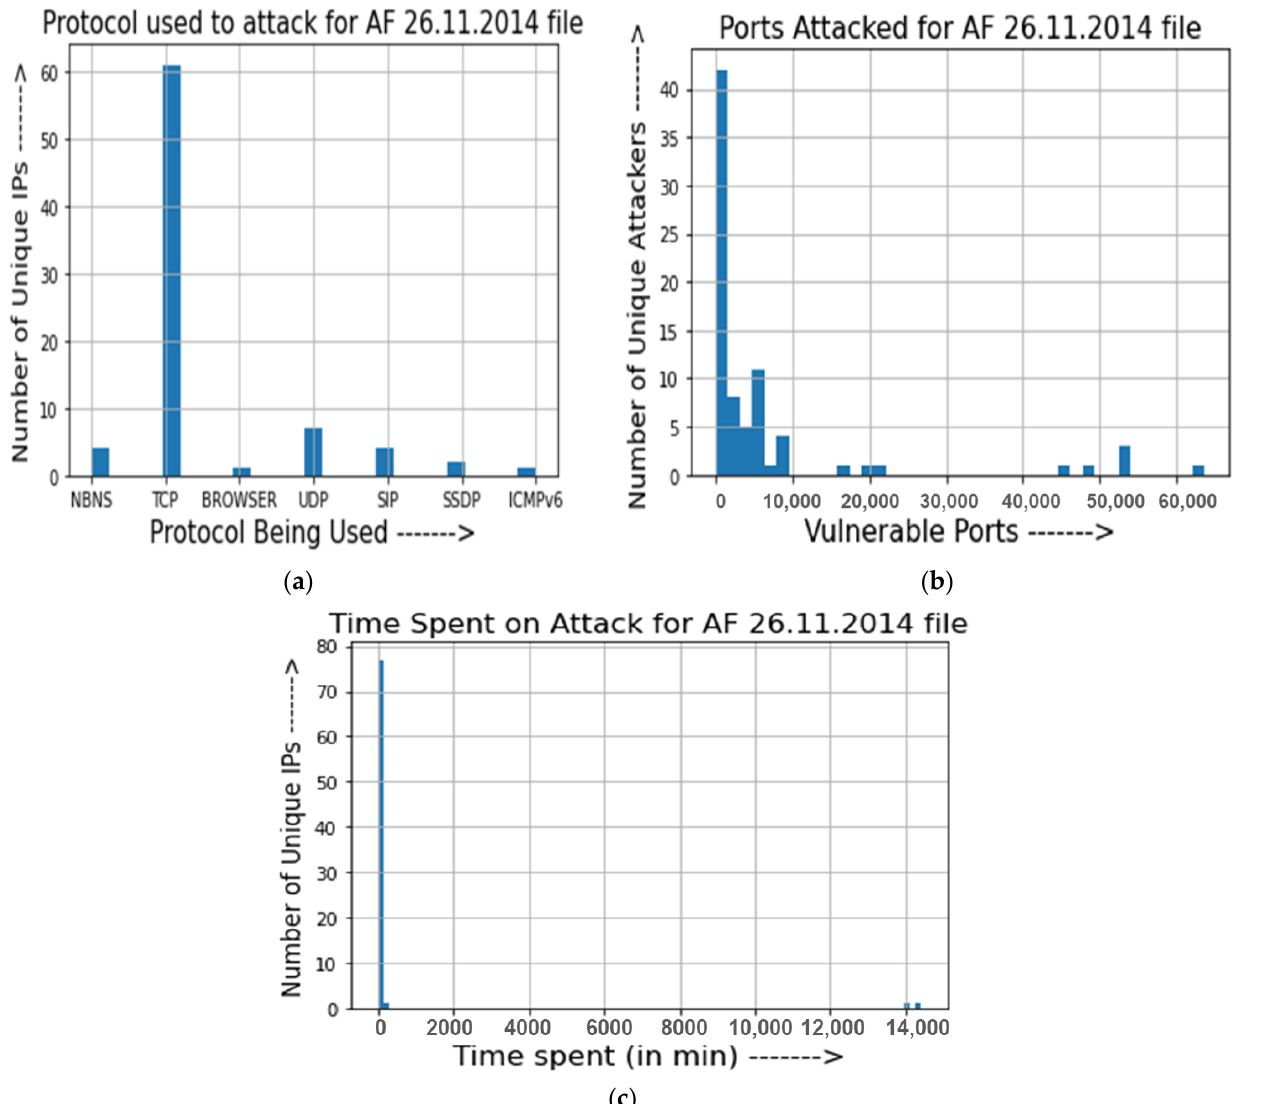
Figure 6. Experimental Results for PCAP file (AF 26.11.2014). ( a ) Number of Unique I.P.s vs. Protocol being used; ( b ) Number of Unique Attackers vs. Vulnerable Ports; ( c ) Number of Unique I.P.s vs. Time Spent.